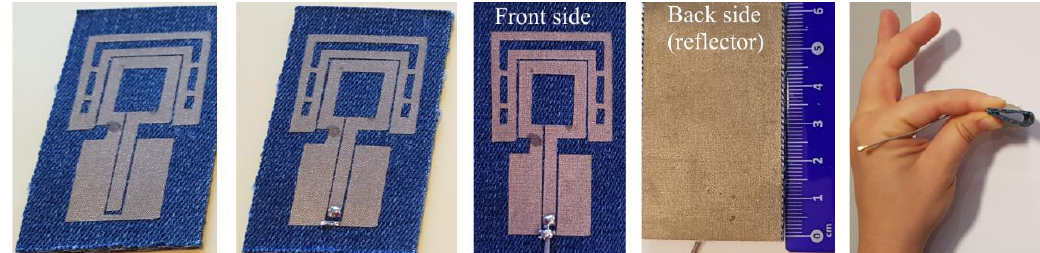
Figure 6. Photographs of the antenna’s prototype during the fabrication process.